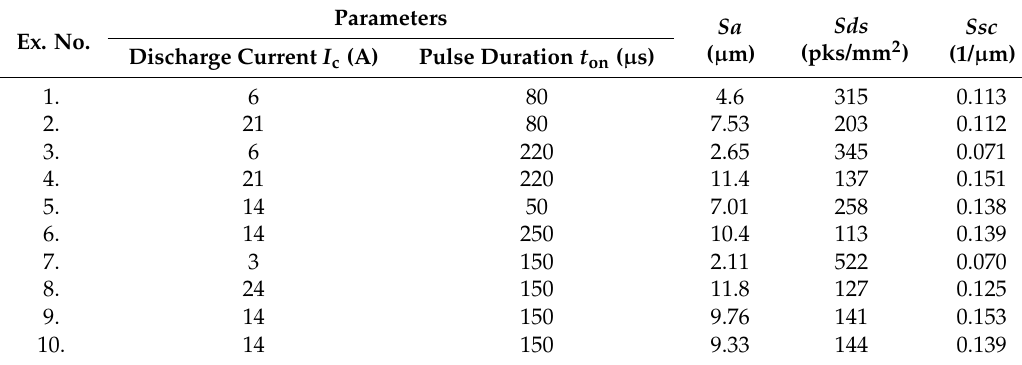
Table 2. Design of the experimental matrix with measured surface roughness parameters.